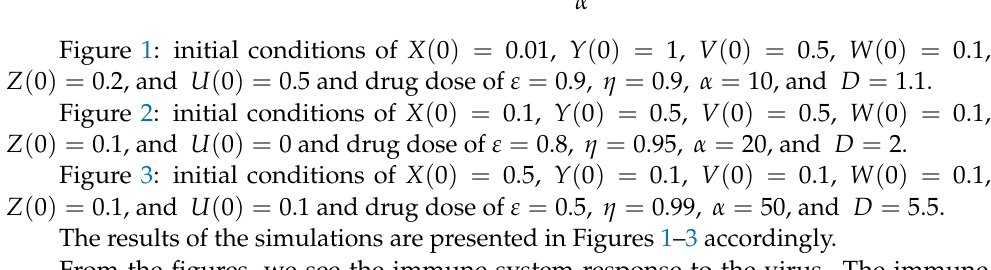
Figure 1: initial conditions of X ( 0 ) = 0.01, Y ( 0 ) = 1, V ( 0 ) = 0.5, W ( 0 ) = 0.1, Z ( 0 ) = 0.2, and U ( 0 ) = 0.5 and drug dose of ε = 0.9, η = 0.9, α = 10, and D = 1.1. Figure 2: initial conditions of X ( 0 ) = 0.1, Y ( 0 ) = 0.5, V ( 0 ) = 0.5, W ( 0 ) = 0.1, Z ( 0 ) = 0.1, and U ( 0 ) = 0 and drug dose of ε = 0.8, η = 0.95, α = 20, and D = 2. Figure 3: initial conditions of X ( 0 ) = 0.5, Y ( 0 ) = 0.1, V ( 0 ) = 0.1, W ( 0 ) = 0.1, Z ( 0 ) = 0.1, and U ( 0 ) = 0.1 and drug dose of ε = 0.5, η = 0.99, α = 50, and D =